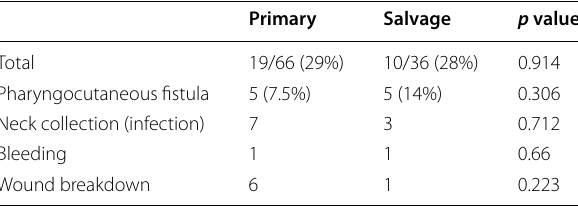
Table 3 Complications after primary and salvage (pharyngo)